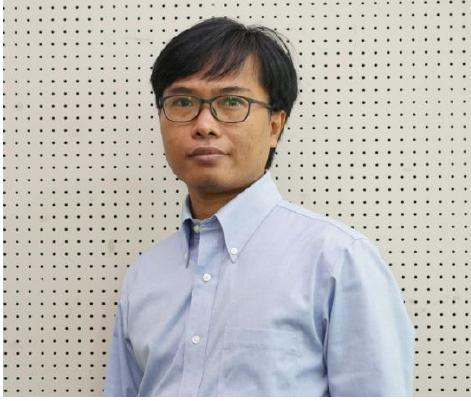
Figure 2. Muhammad Roil Bilad.